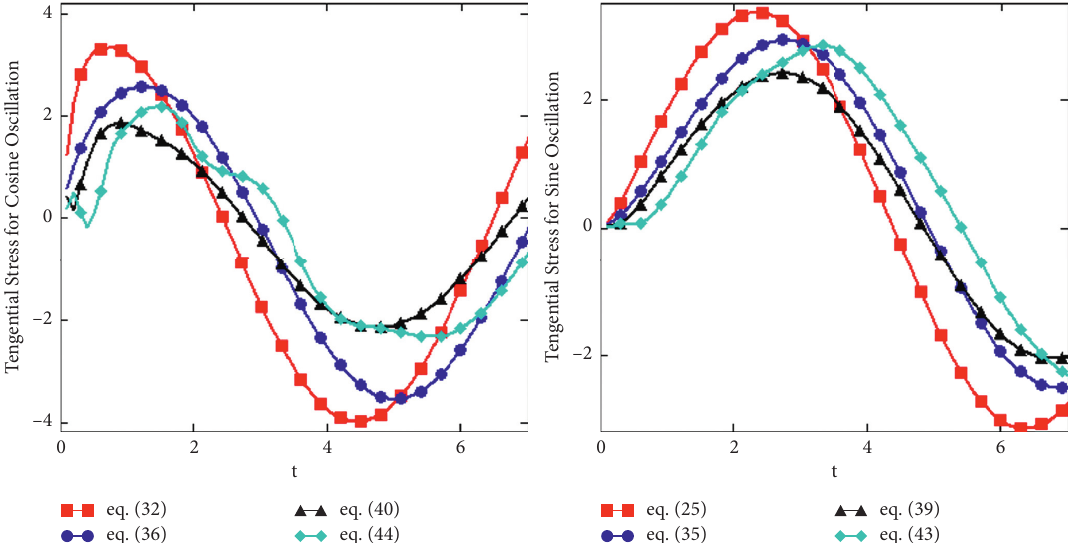
� 0 . 1, β � 0 . 7, λ � 0 . 3, α � 0 . 5, c � 2, X � 0 . 55, and Y � 0 . 15. 2 1